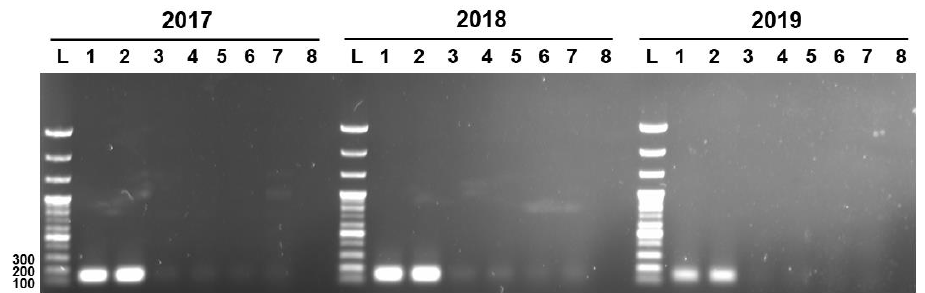
Figure 3. Detection of PCR product by strain-specific primers. Numbers at the top indicate the pri-